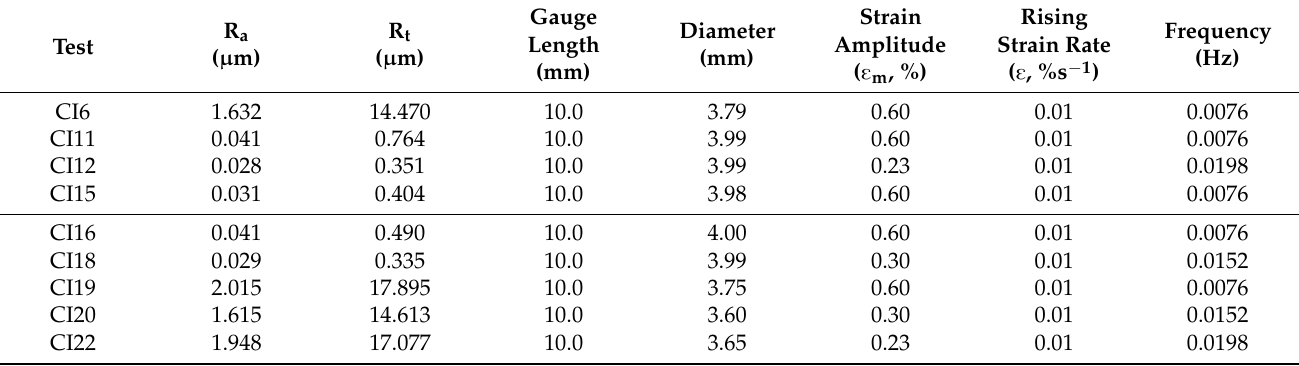
Table 2. Some test parameters and resulting crack growth rates calculated using the DCPD signal and SEM fractography. R a : arithmetic average roughness value [20]; R t : total height of the roughness profile